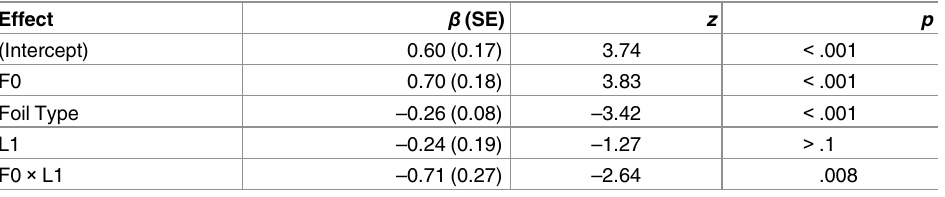
Table 2. Best logit mixed-effects model on accuracyof functionally monolingual listeners (French lis- teners’ performance on non-word foils in the AL with No F0 cues as baseline) a